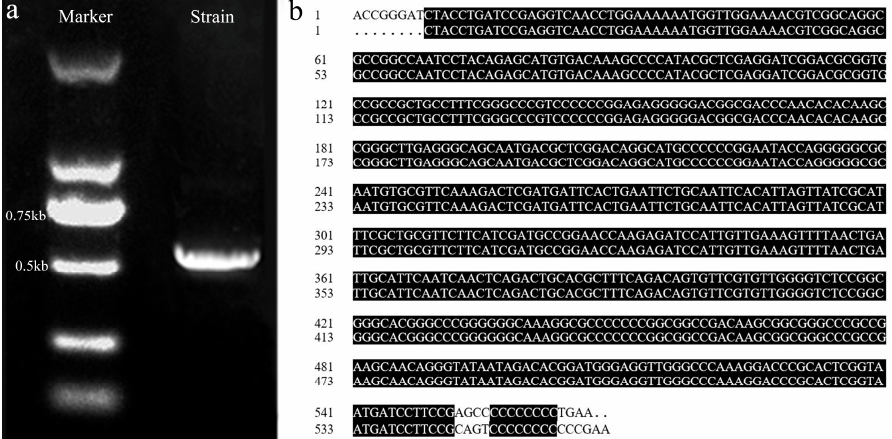
Figure 6. Molecular biology identification of isolated strain. ( a ) Agarose gel electrophoresis of the isolated strain; ( b ) the result of the isolated strain in blast. Comparison by blast; the upper line represents the speculative sequences, and the lower line represents the resulting sequences.